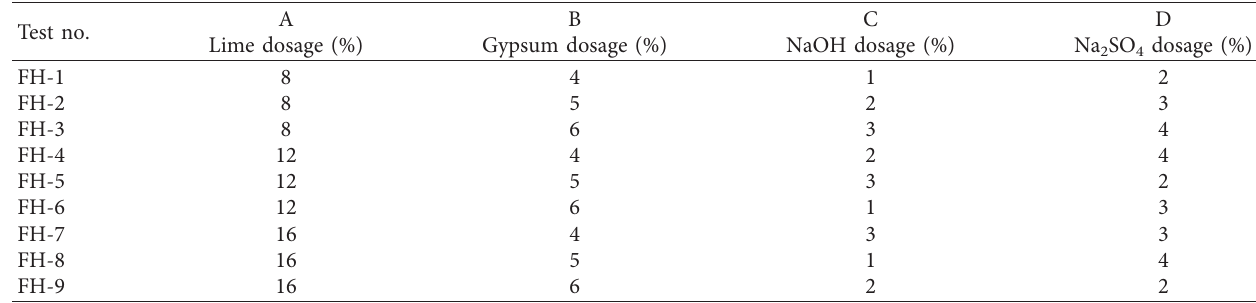
Table 5: Orthogonal test scheme of compound